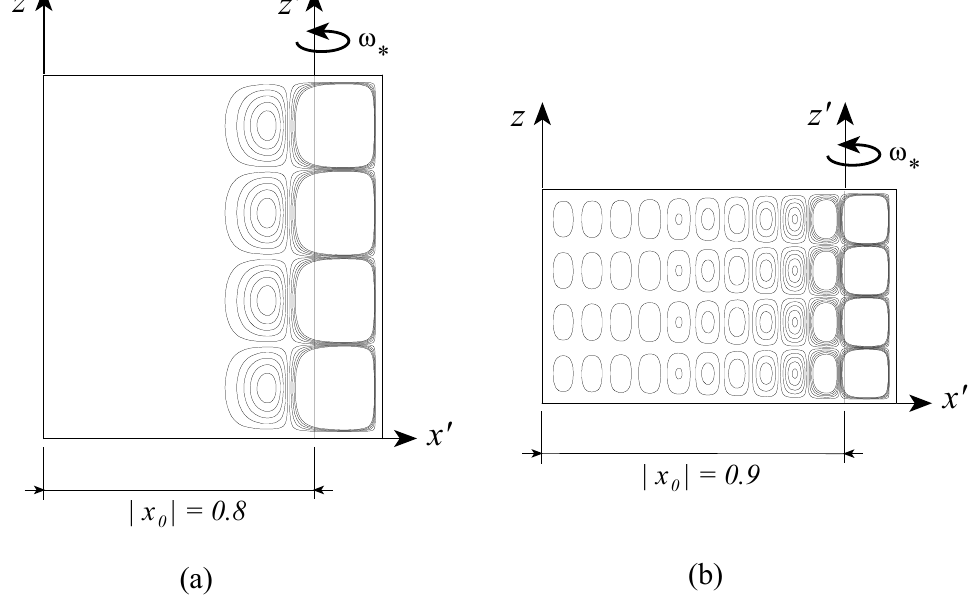
Figure 11. The convective flow field at marginal stability for two di ff erent values of | x 0 | ; 10 streamlines equally divided between ψ min and ψ max . ( a ) streamlines for the axis of rotation located at | x 0 | = 0.8; ( b ) streamlines for the axis of rotation located at | x 0 | = 0.9; (Reprinted from [41], with permission from Elsevier Science Ltd.)